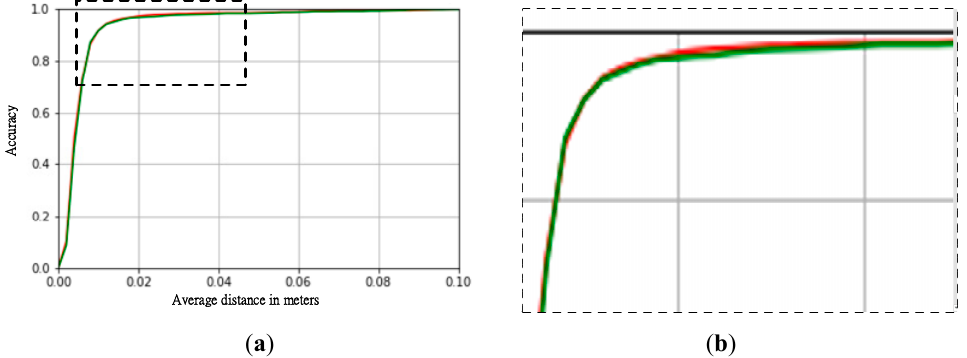
Figure 6. ( a ) The accuracy-threshold curves of DenseFusion [11] (green line) and the proposed method (red line) based on LINEMOD. ( b ) A closer look of the enlarged portion indicated by the black-dash rectangle in (a).